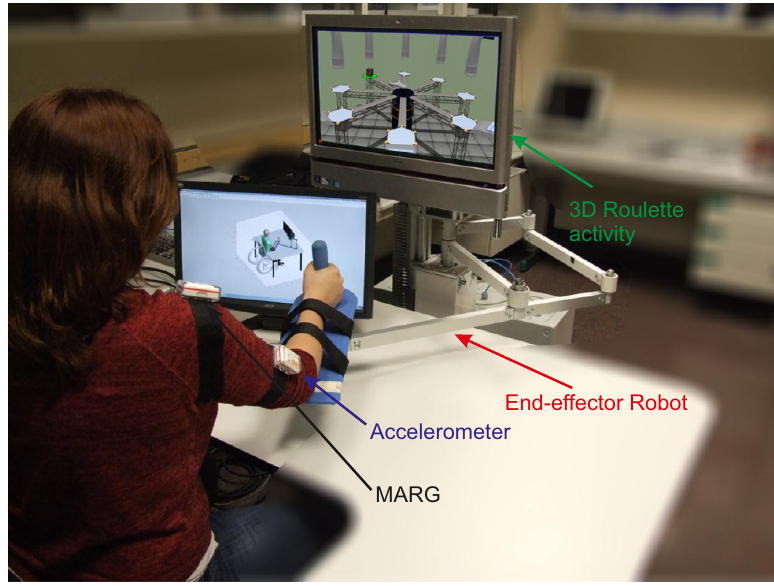
Figure 4. Subject wearing the sensors, the accelerometer and the MARG, grasping the end effector of the robot and performing the 3D roulette